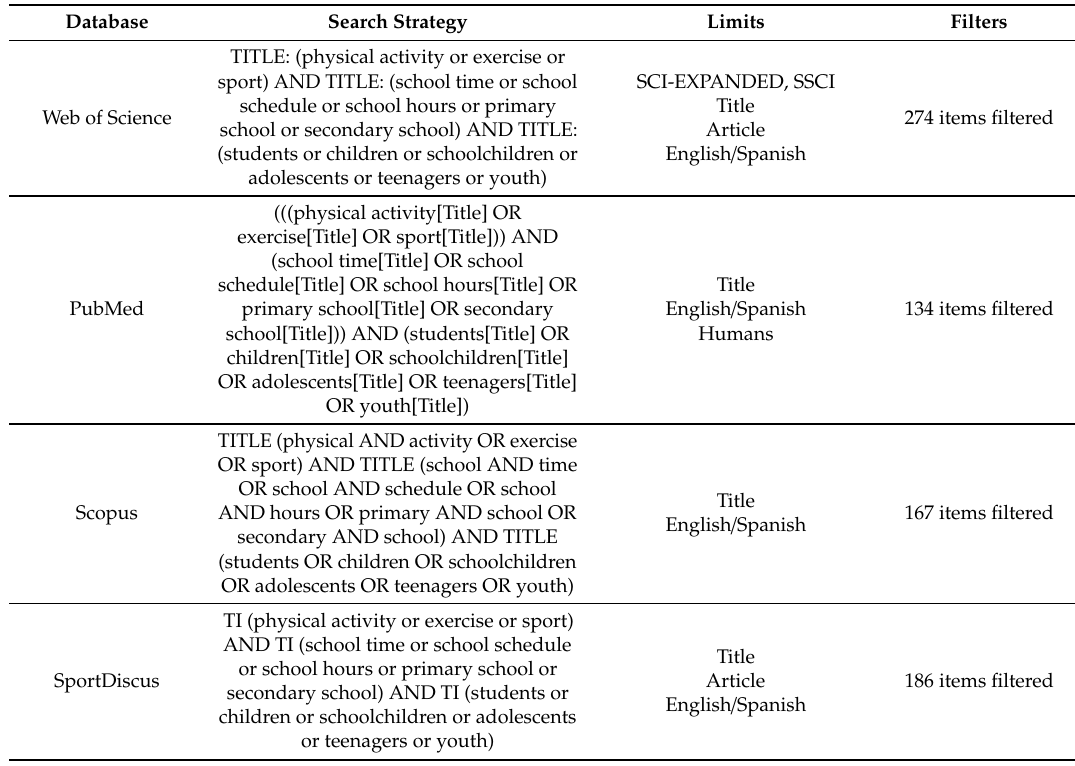
Table 1. Search strategy in